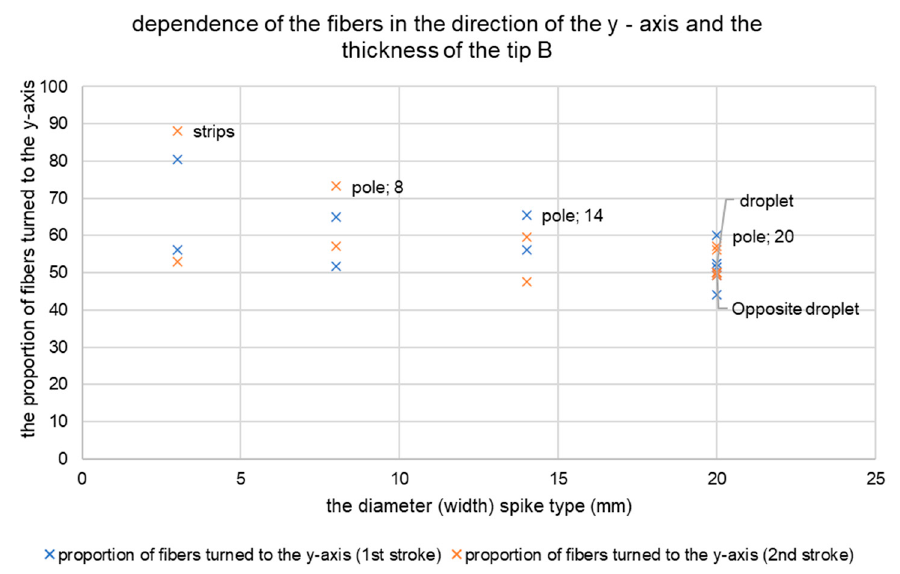
Figure 11. Dependence of fibres in the direction of the y -axis and the thickness of the tip B. In determining the appropriate distance between the tips, 1.5 times the length of the fibre used showed the best results. The distance of 90 mm represents 1.5 times the fibre with a length of 60 mm. They reached a value of 80–90%. Worse results showed spacing of 60 mm. This distance caused the fibres to accumulate and movement to the edge of the form. Therefore, these results are not relevant and are not in the resulting graph. The tip distance of 120 mm did not rotate a sufficient number of fibres in the y -axis direction. In the first move and also in the second move it was only 40–60%. The results are shown in Figure 12.